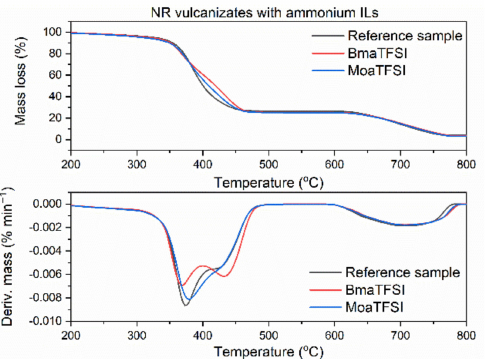
Figure 7. TG and DTG curves of the NR vulcanizates containing ammonium ILs with TFSI anion.